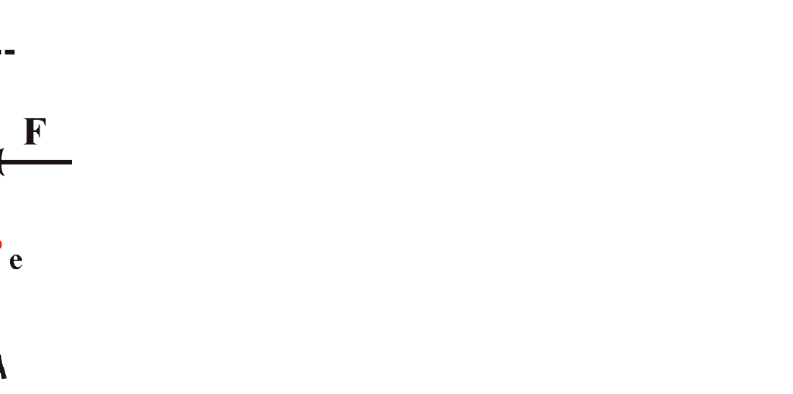
Figure 1. Energy band diagram of field electron emission from metal. E F and E 0 are respectively the Fermi level and vacuum level of metal cathode under zero field. When a field F is applied on the surface, the vacuum barrier will bend. Electrons can tunnel into the vacuum if the barrier width is in several nanometers scale.